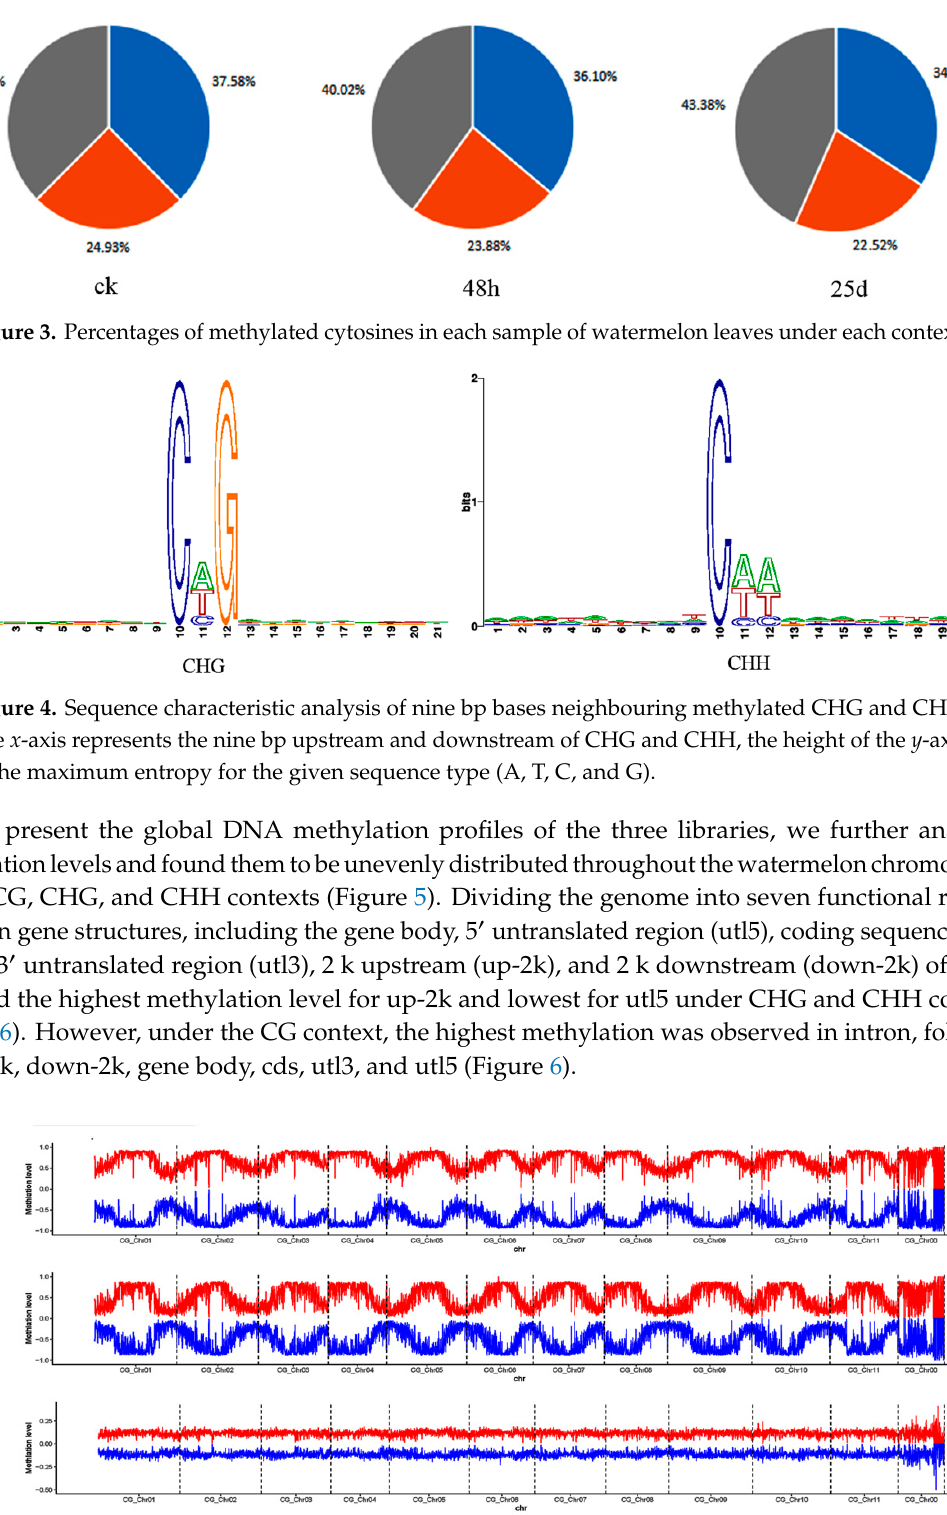
Figure 5. Cont Figure 5. Cont. Figure 5. Cont. Figure 5. Cont.